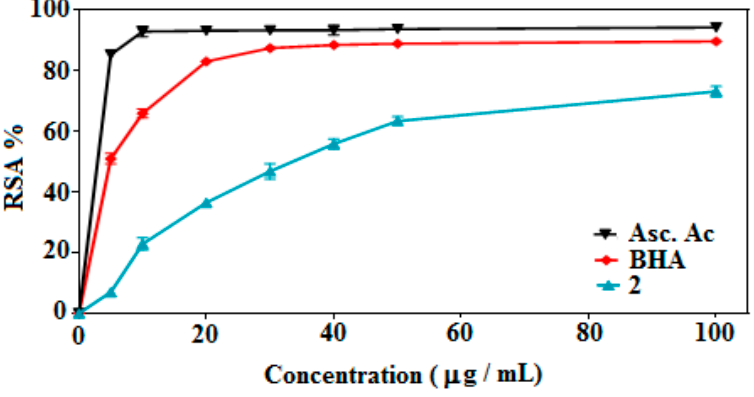
Figure 8. DPPH radical scavenging activity of compound 2 .